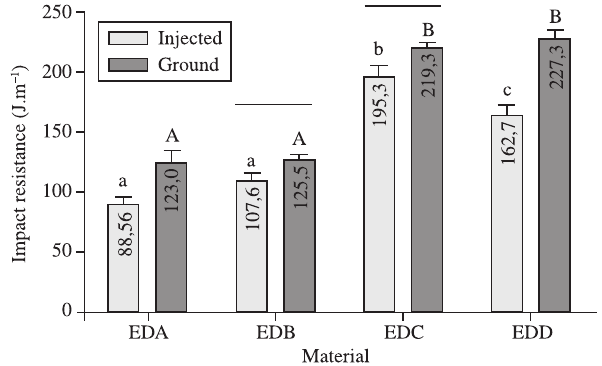
Figure 2. Impact resistance. Comparison (2-way ANOVA - Bonferroni - p < 0.05) of commercial and experimental materials (ground and injected).